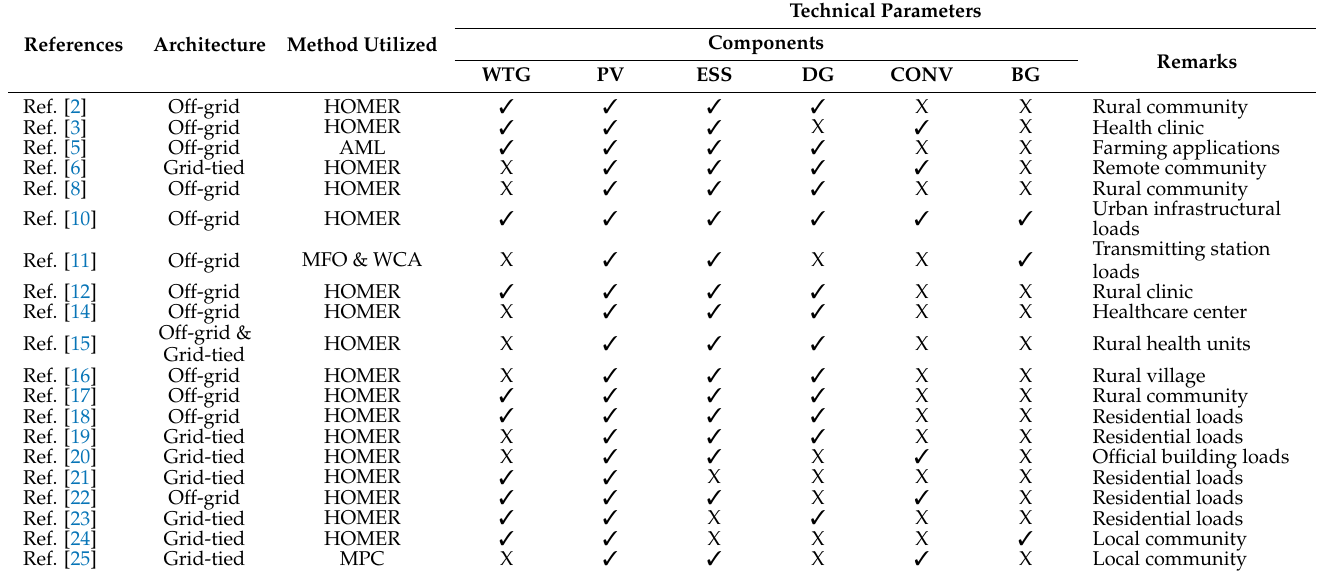
Table 1. An overview of recent studies on hybrid energy